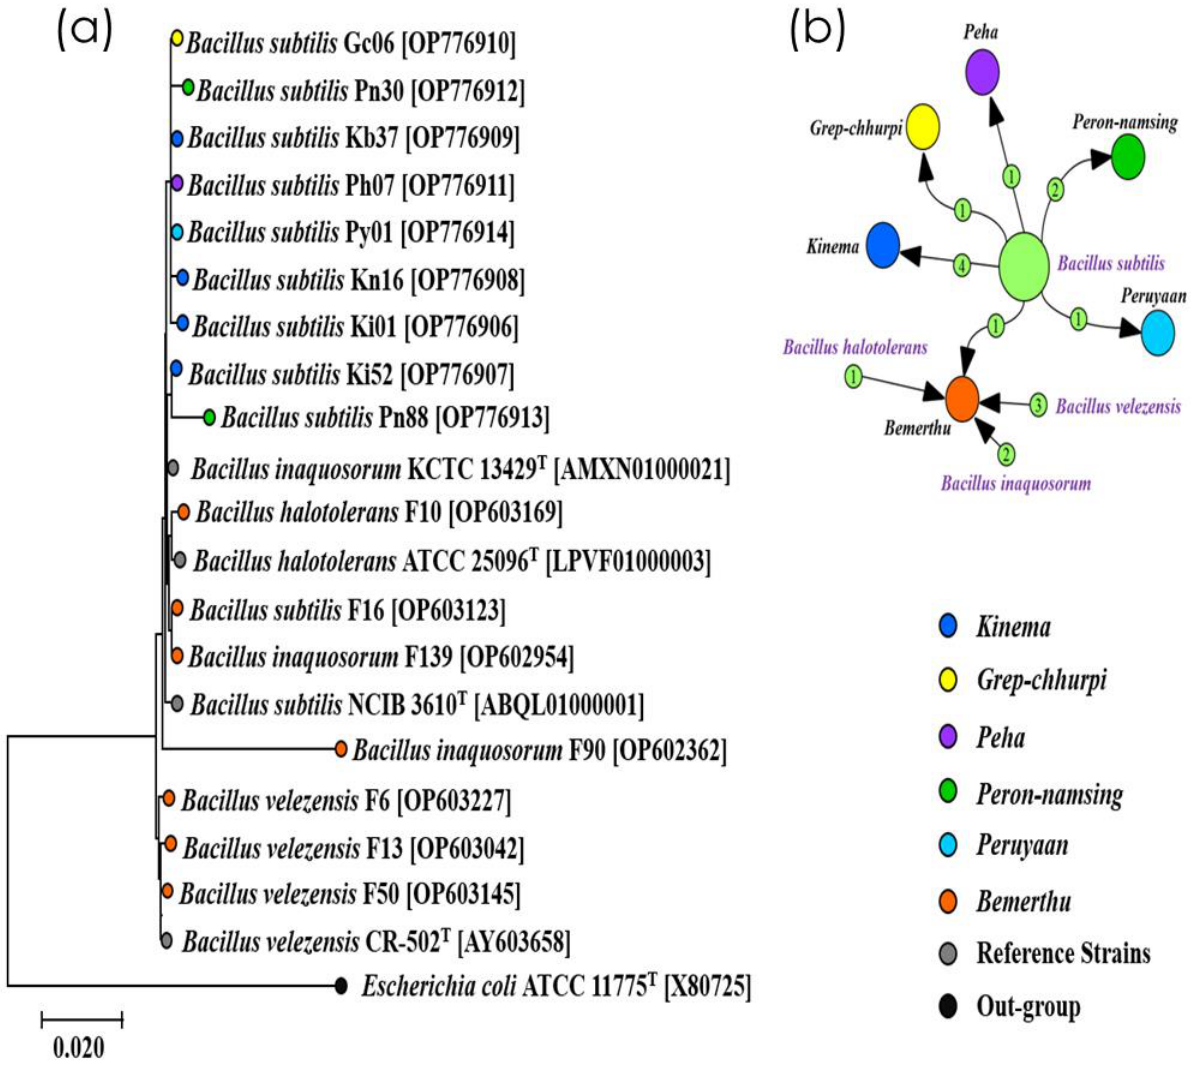
Figure 2. ( a ) Neighbour-joining phylogenetic analysis using Molecular Evolutionary Genetics Analy- sis 11 (MEGA 11.0.13) based on 16S rRNA gene sequences of bacterial strains isolated from naturally fermented soybean foods. The percentage of replicate trees in which the associated bacterial taxa clustered together was 1000 replicates in the bootstrap test with the evolutionary distances computed using the Kimura 2-parameter method. Bacillus subtilis NCIB 3610 T [ABQL01000001], Bacillus velezen- sis CR-502 T [AY603658], Bacillus inaquosorum KCTC 13429 T [AMXN01000021] and Bacillus halotolerans ATCC 25096 T [LPVF01000003] were used as the reference type strain acquired from NCBI database. Escherichia coli ATCC 11775 T X80725 was used as the outgroup; ( b ) The shared and unique distribution of Bacillus species with fibrinolytic properties identified from naturally fermented soybean foods of the Eastern Himalayas, represented by a graphical constructed network.